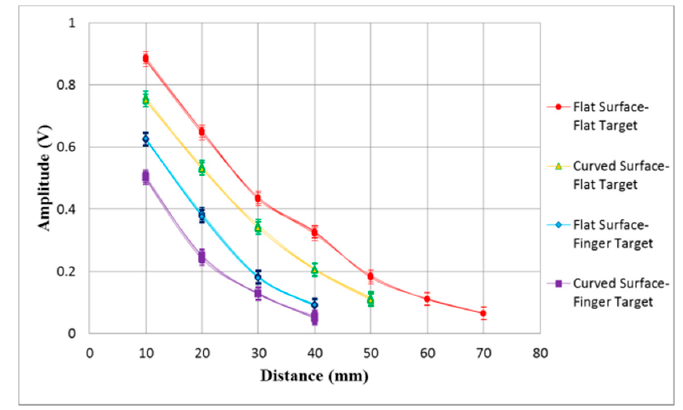
Figure 21. A transparent CMUT mounted on a 40 mm curvature radius surface to detect a finger.